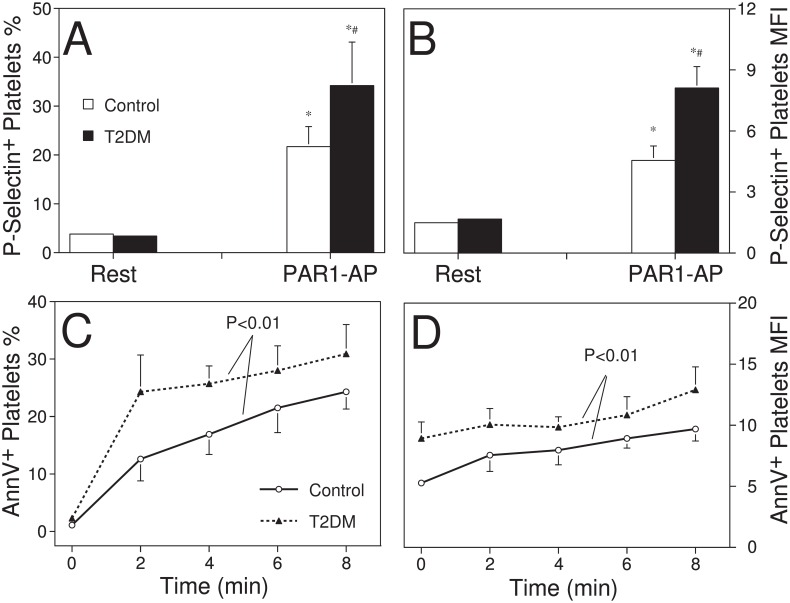
Platelets are hyperreactive in T2DM patients.Panels A and B: Hirudinized whole blood of non-diabetic (open bars) and T2DM subjects (filled bars) was incubated in the presence of PE-conjugated anti-P-selectin MAb and in the absence or presence of 4 μM PAR1-AP for 20 min at 22°C. Platelet P-selectin expression was determined by flow cytometry. The data plotted are mean±SEM the percentages (panel A) and mean fluorescence intensities (panel B) of P-selectin positive platelets in the total platelet population; n = 8. *P<0.05 vs unstimulated samples; #P<0.05 vs non-diabetic controls. Panels C and D: Hirudinized whole blood was incubated at 37°C in the presence of 10 μM PAR1-AP during 8 min. At the time points of 0, 2, 4, 6, and 8 min, blood aliquots were added into the binding buffer containing PE-conjugated annexin V and FITC-CD42a MAb, and incubated for 20 min at 22°C. Thereafter, annexin V-binding of single platelets was analysed by flow cytometry. Mean±SEMs of the percentages (panel C) and mean fluorescence intensities (panel D) of annexin V binding positive platelets are plotted, n = 7; P value of repeated measurements ANOVA indicates the difference between non-diabetic (open circles and solid line) and T2DM subjects (filled triangles and dash line).